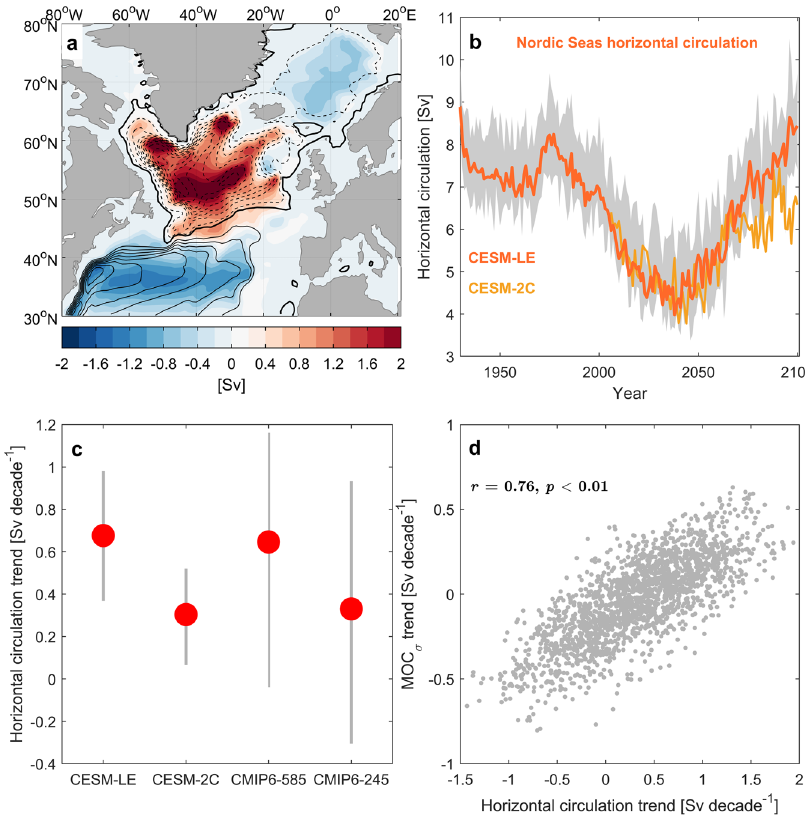
Fig. 3 | Horizontal circulation. a Trends in horizontal circulation (barotropic streamfunction; color; unit: Sv decade − 1 ) between 2051-2100 in CESM-LE. Mean values for 2006 – 2100 are shown by contour-lines (contour interval: 5 Sv; dashed linesindicatenegativevalues). b StrengthofthehorizontalcirculationintheNordic Seasquanti fi edastheabsolutevalueoftheminimumbarotropicstreamfunctionin CESM-LE (63-76°N, 10°W-10°E). Solid line shows the ensemble mean and the